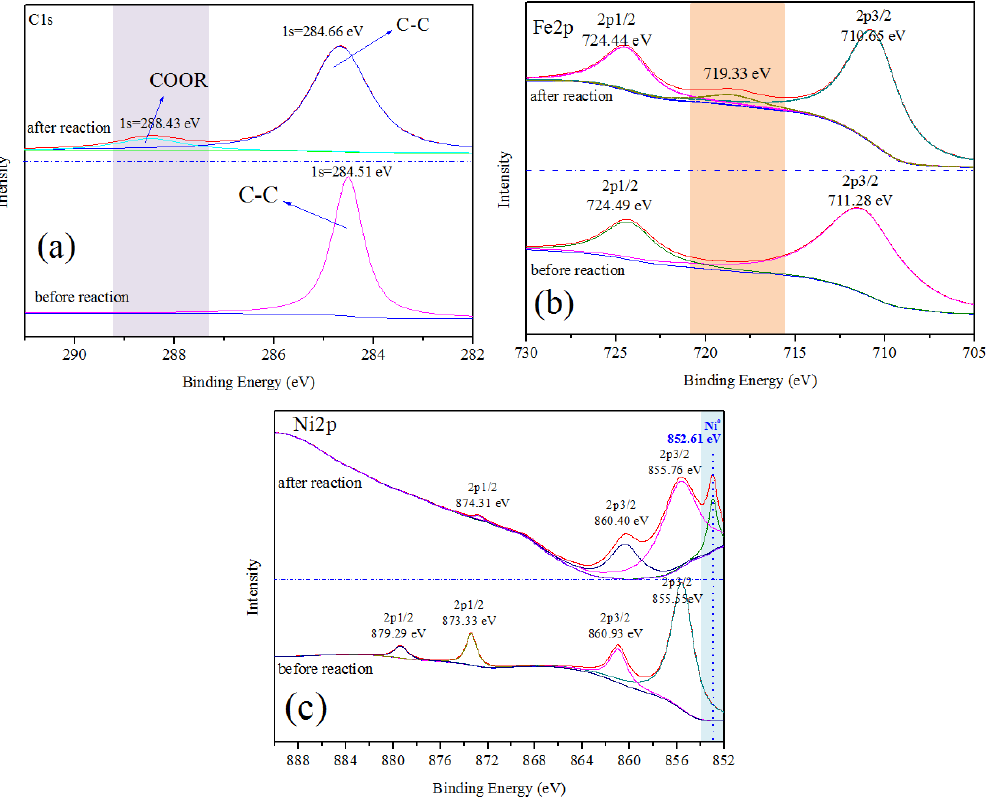
Figure 5. XPS patterns of Fe-Ni / char catalyst before and after reaction. ( a ) C1s spectra; ( b ) Fe2p spectra; ( c ) Ni2p